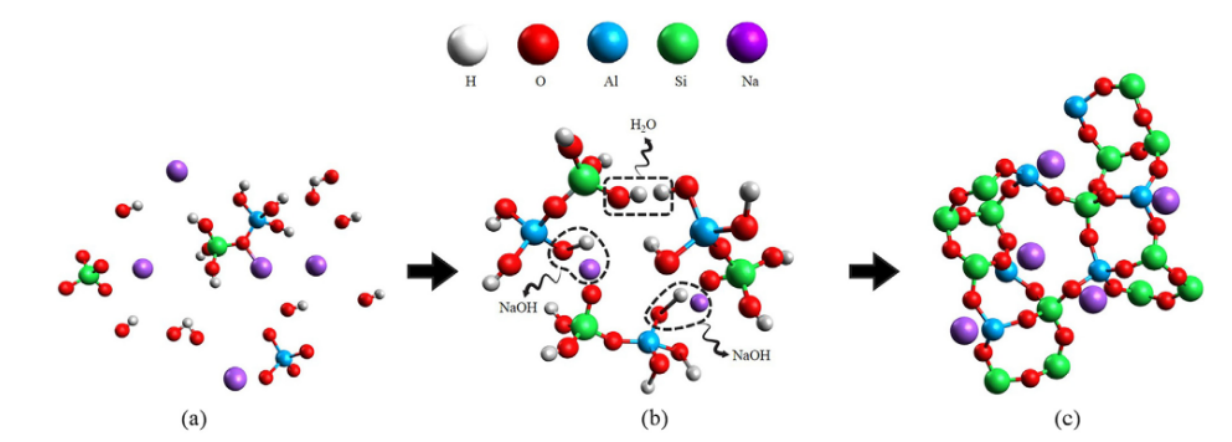
Figure 6: (a) Recombination of aluminosilicate (b) Polymerization to form gel (c) Polymerization [50].